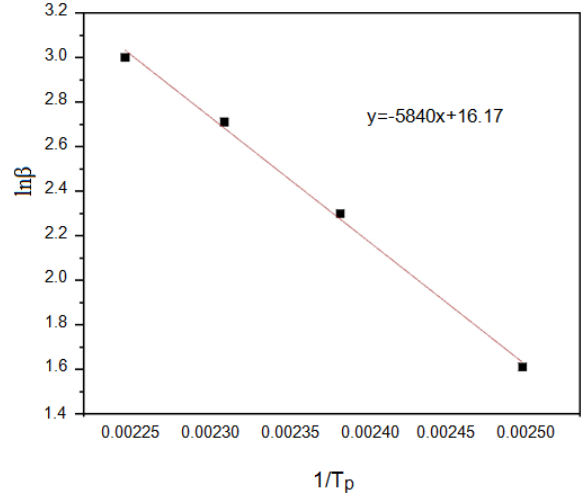
Figure 7. Linear regression equation between ln β and 1/T p .